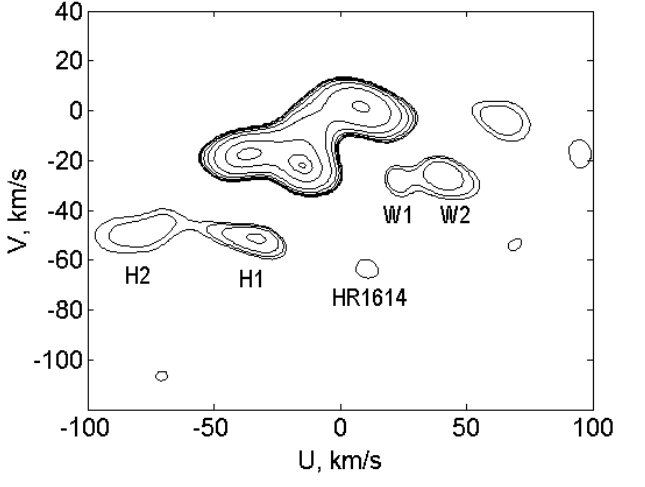
Fig. 1. Wavelet map of UV velocities constructed using ∼ 17 000 single stars from the Hipparcos catalog (ESA 1997) with relative parallax errors of ≤